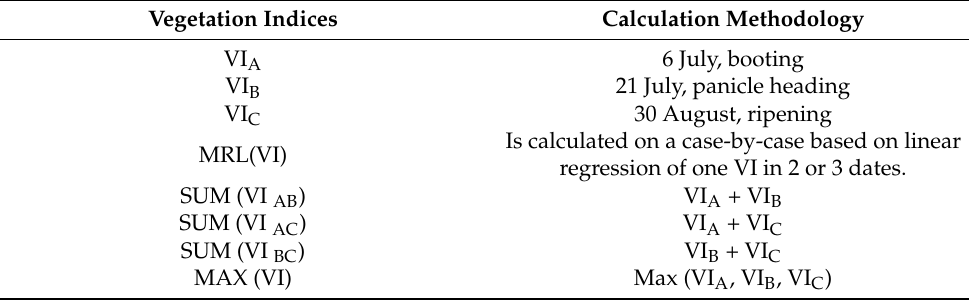
Table 2. Multitemporal vegetation indices and calculation methodology.